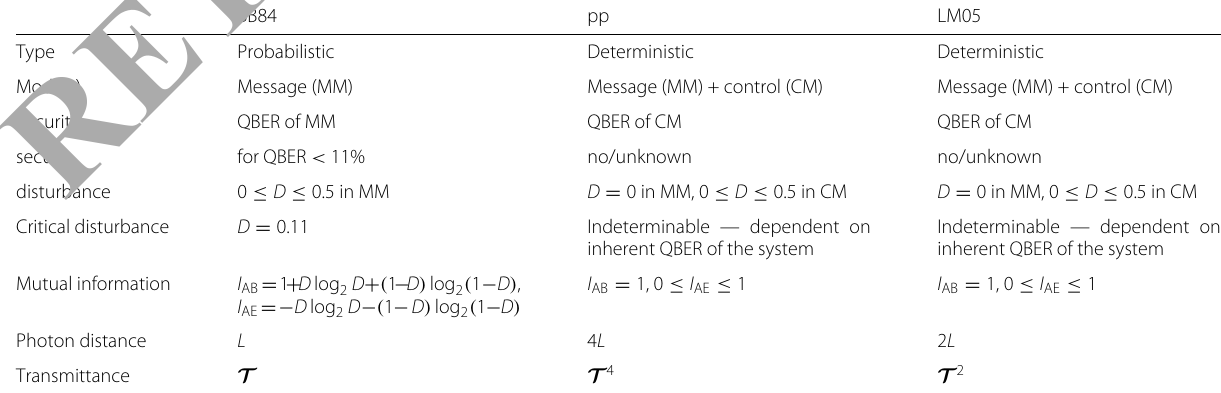
Table 1 Properties of an BB84-like protocol under an arbitrary attack compared with properties of pp-like and LM05-like protocols under the attack presented in the paper